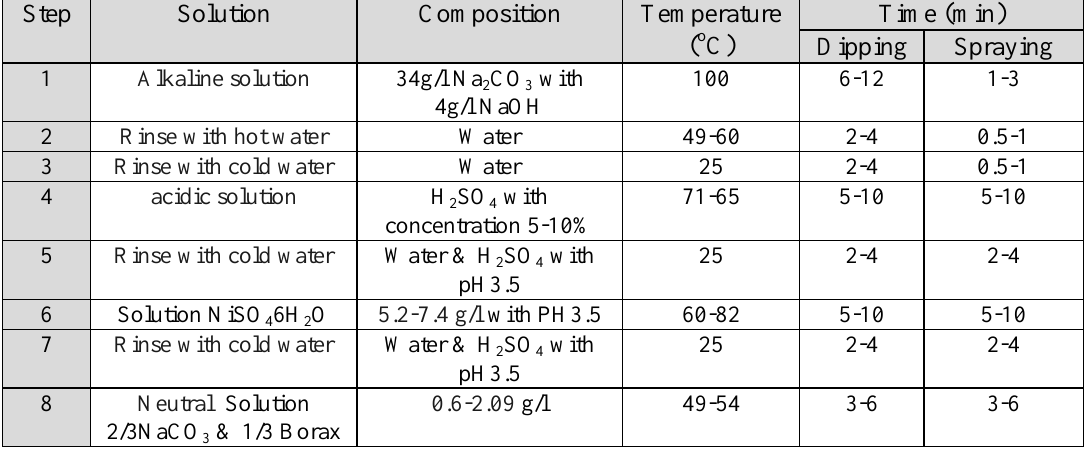
Table 5: Materials and chemical cleaning solutions used